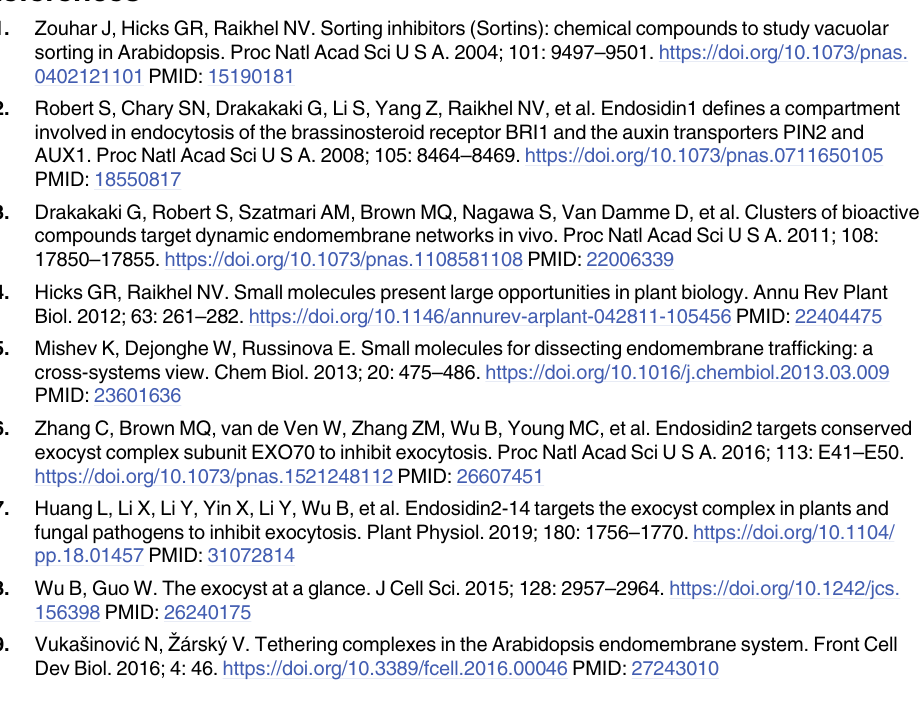
BFA for 1 hour. In G seedlings were treated with BFA for 1.5 hours and then co-treated with ES2 and BFA for 1 hour. Note that in F, the large fluorescent compartments are absent.